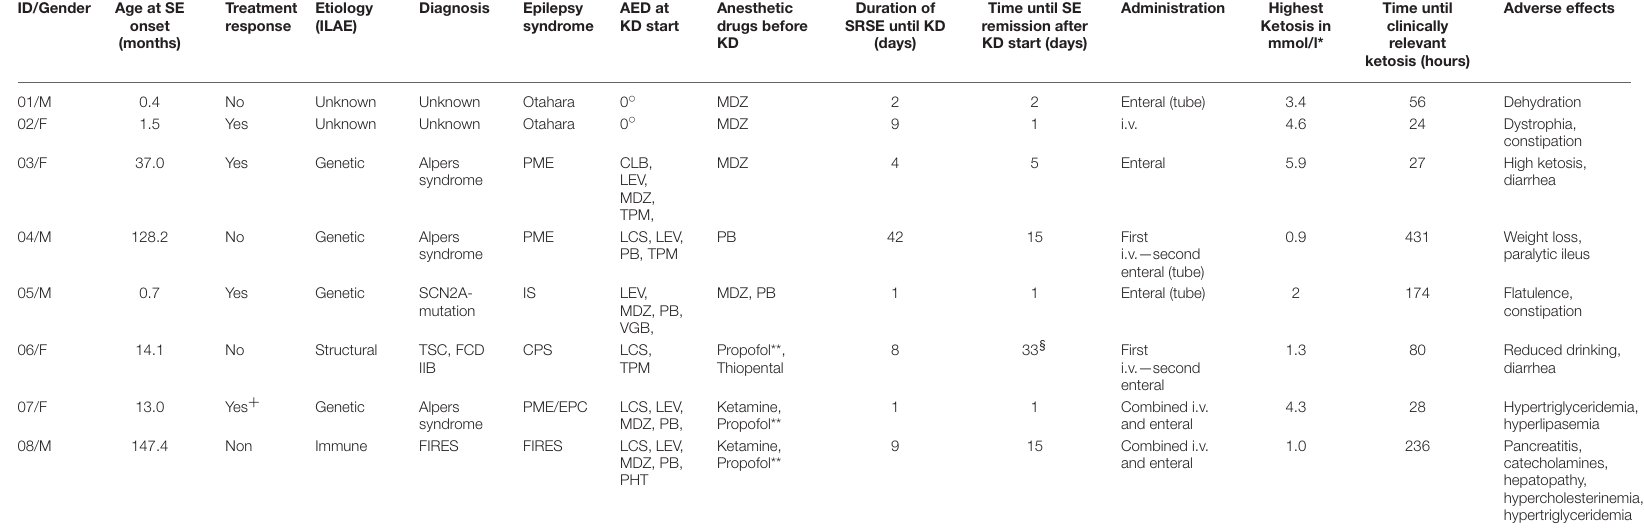
TABLE 2 | Patients characteristics and KD